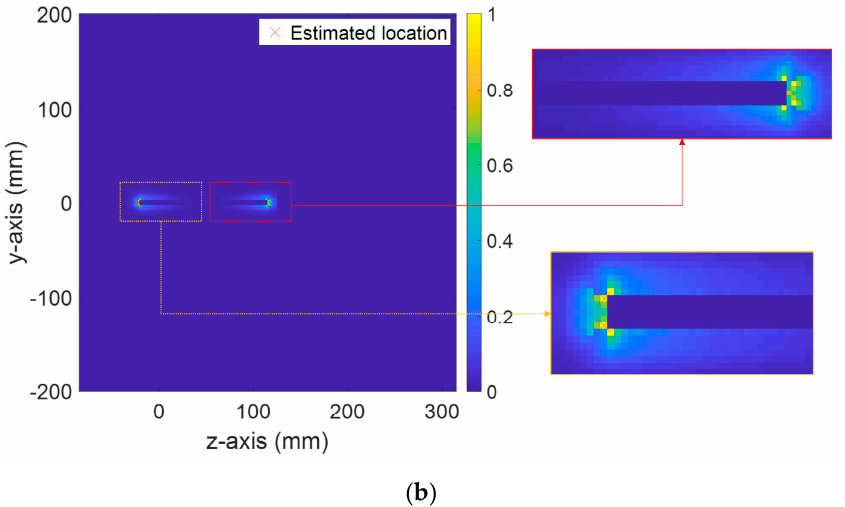
Figure 16. The distribution of normalized maximum electric field power over the complete simulation time interval in a square with a length of 40 cm around the electrode system. ( a ) Cut-plane xz ; ( b ) cut-plane yz .